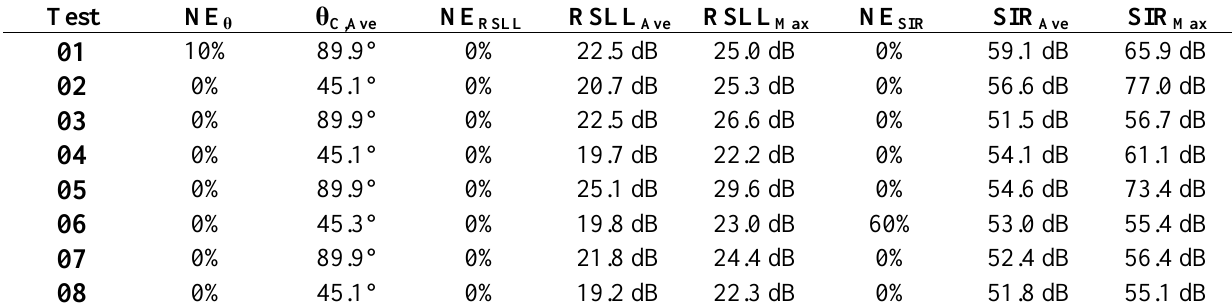
Table 4. Test results of the second application of GA-MMC